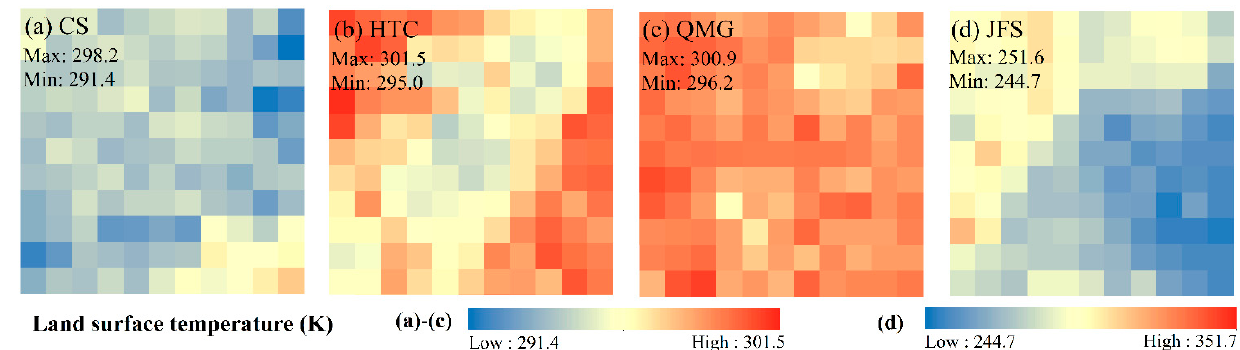
Figure 12. ASTER LST images over the sites: ( a – c ) acquired on 14 August 2018 and ( d ) acquired on 2 January 2018.